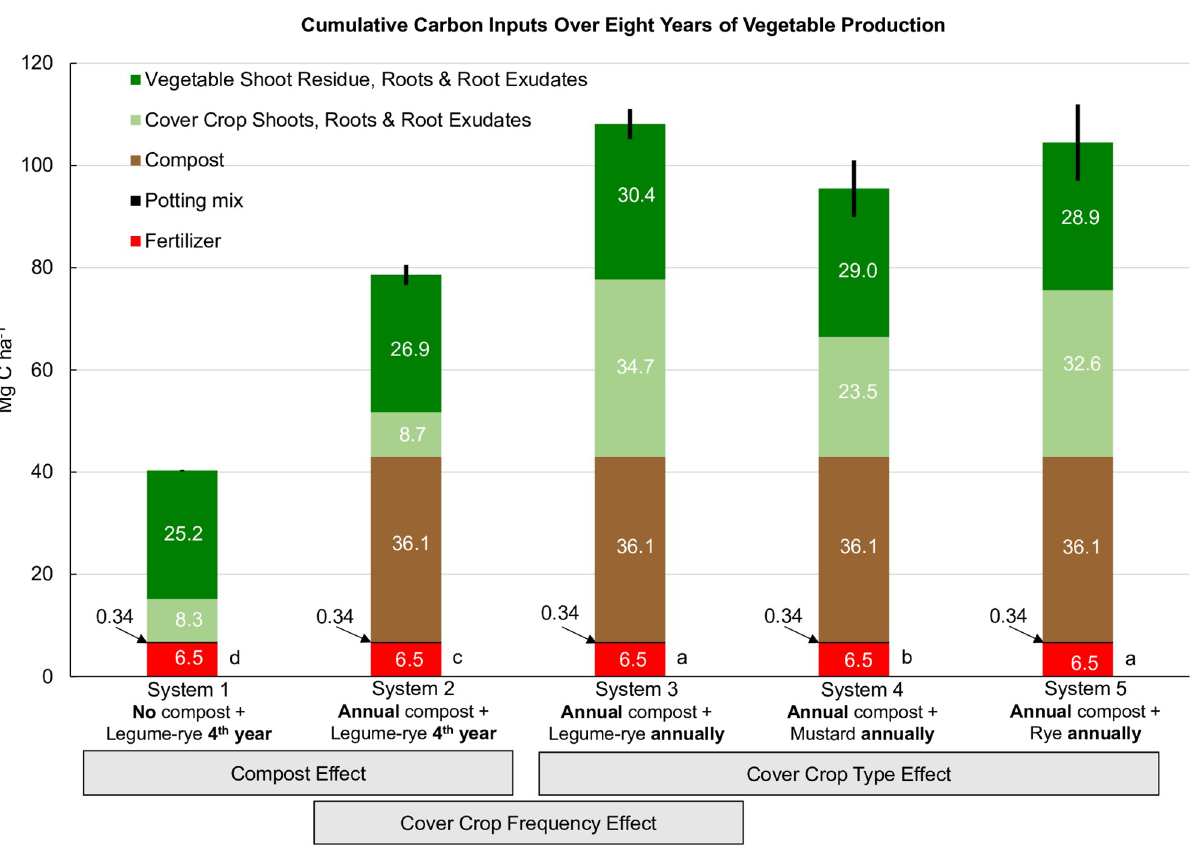
Fig 1. Cumulative carbon inputs over eight years of vegetable production. Sum of mean carbon inputs over eight years of intensive vegetable cropping from fertilizer, vegetable transplant potting mix, urban yard waste compost, cover crops and vegetables in five organic vegetable systems in Salinas, CA. Systems differed by annual compost additions (0 vs. 7.6 Mg ha -1 before each vegetable crop), cover crop type (legume-rye, mustard or cereal rye alone) and cover cropping frequency (quadrennially vs. annually planted). Inputs from cover crops include shoots, estimates of roots and root exudates, and for vegetables included post-harvest vegetable shoot residues of broccoli and lettuce and estimates of their roots and root exudates. Bar heights equal the sum of all carbon inputs with the 95% confidence interval error bar for total carbon input. Mean total estimated carbon inputs (Mg ha - 1 ) were 40.3 (System 1), 78.5 (System 2), 108.1 (System 3), 95.4 (System 4) and 104.4 (System 5); due to rounding, the sum of the values within the bars for each system may differ slightly from the mean totals. Different lower case letters above the x-axis to the right of each bar indicate that the total carbon means are significantly different based on the Tukey-Kramer adjusted family-wise error rate of (P � 0.05).